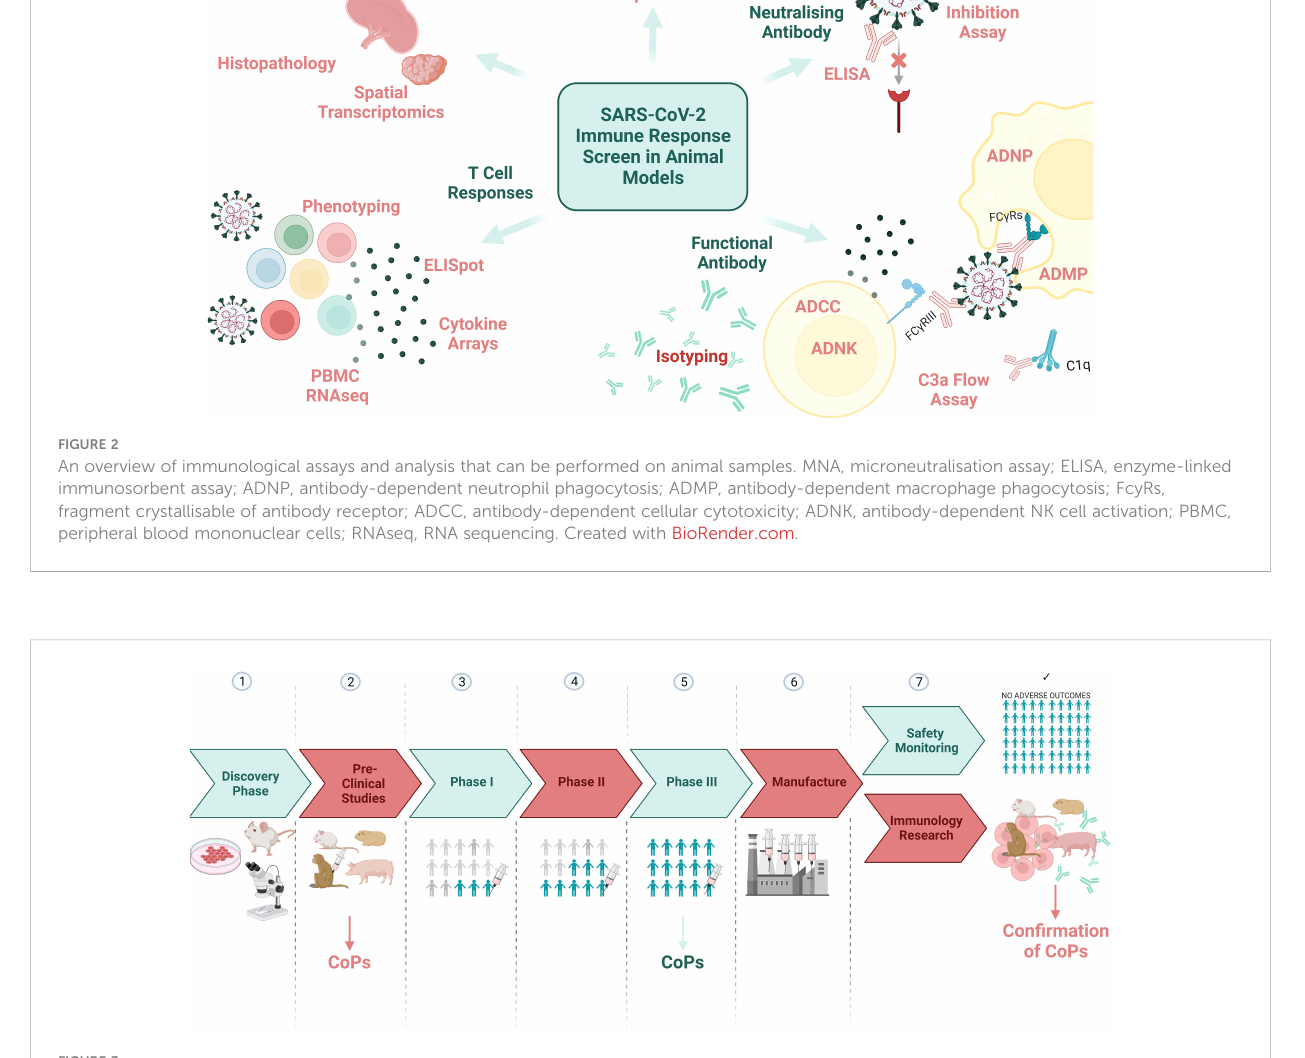
FIGURE 3 A vaccine development pipeline highlighting the stages where candidate CoPs can be identi fi ed and con fi rmed. Created with